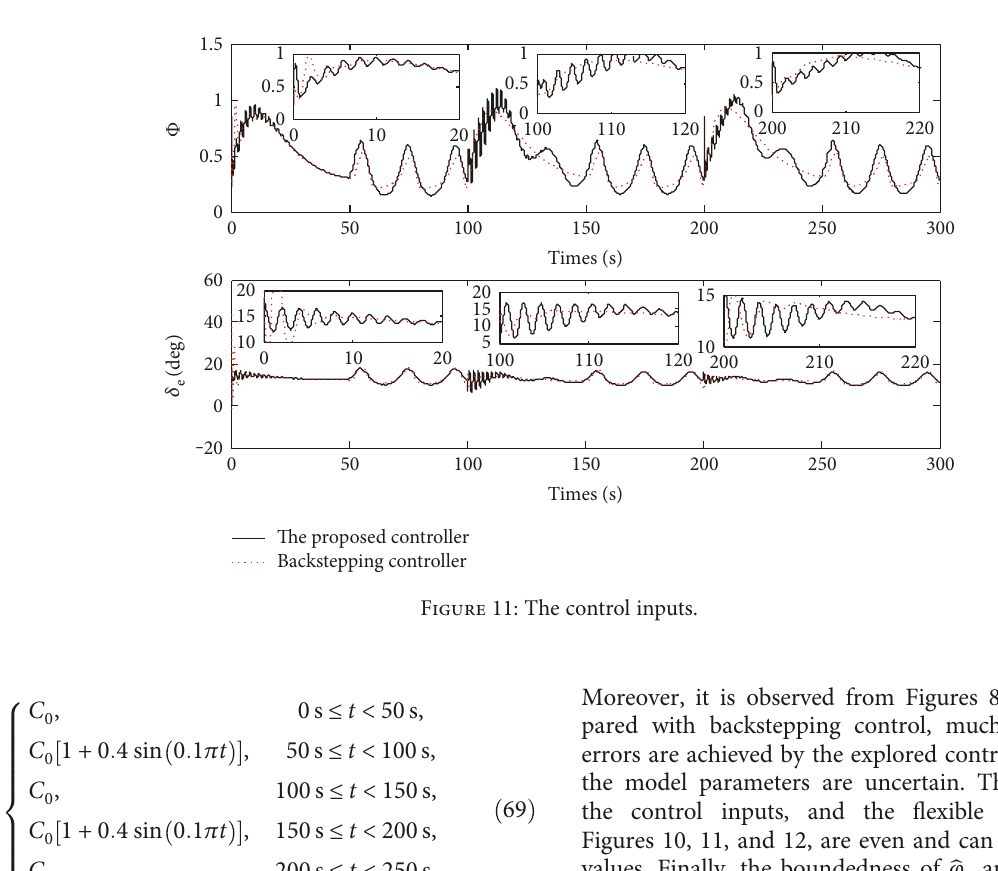
Figure 10: The fl ight-path angle, pitch angle, and pitch rate.